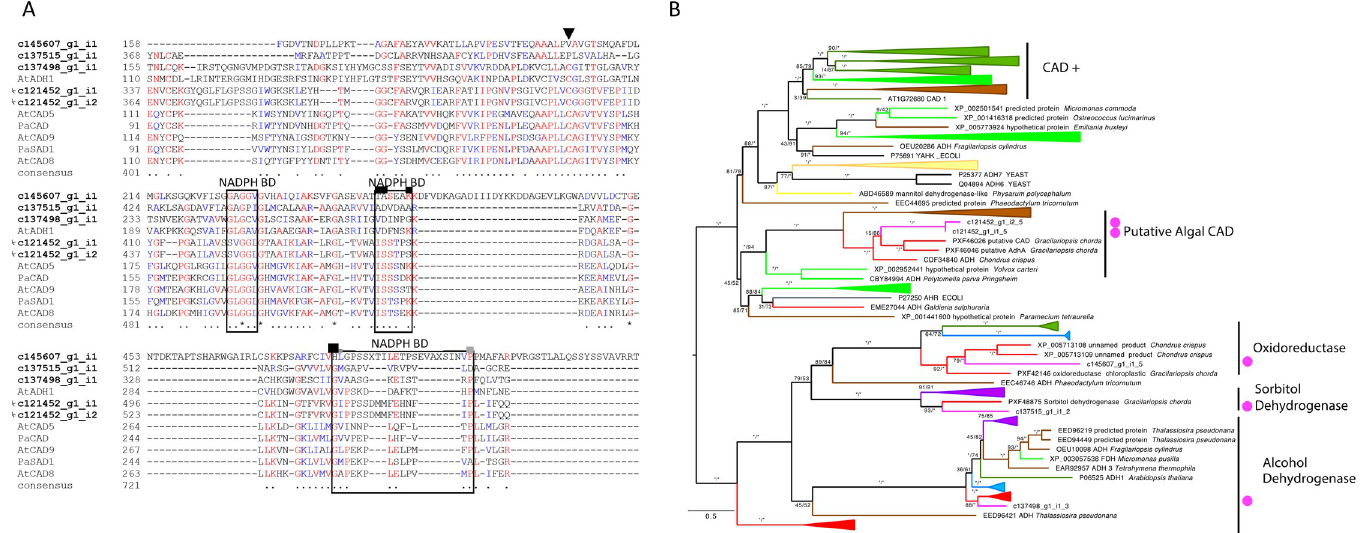
Fig 4. CAD candidates from C . tuberculosum in relation to plants and other taxa. (A) Partial alignment of C . tuberculosum CAD sequence candidates (bolded) with land plant CAD sequences. Zn +2 ion coordinating and proton shuttling residues are indicated with the black triangle, NADPH or NADH interacting residues are boxed. Hydrostatic interaction forming residues are indicated with a black box. Putative substrate-binding residues are indicated with grey boxes [55–57]. (B) CAD maximum likelihood gene tree showing relationships between C . tuberculosum (magenta dots) and other taxa (Embryophyta–dark green, Chlorophyta–light green, Rhodophyta– red, Animalia and Opisthokonta–purple, Bacteria and Cyanobacteria–blue, Oomycota, Mycetozoa and Fungi–yellow, Ochrophyta–brown). Alcohol dehydrogenase (ADH) sequences from yeast, and aldehyde reductase (YAHK and AHR) sequences from E . coli were used as the ADH family is closely related to that of CAD [58, 59]. Functionally demonstrated plant CADs are labelled (+). Additional functional groups are labelled. Ultrafast bootstrap values > 95 are marked by � . Model = LG+G4. Sites with � 80% occupancy were removed. Accession numbers can be found in S1 Appendix.